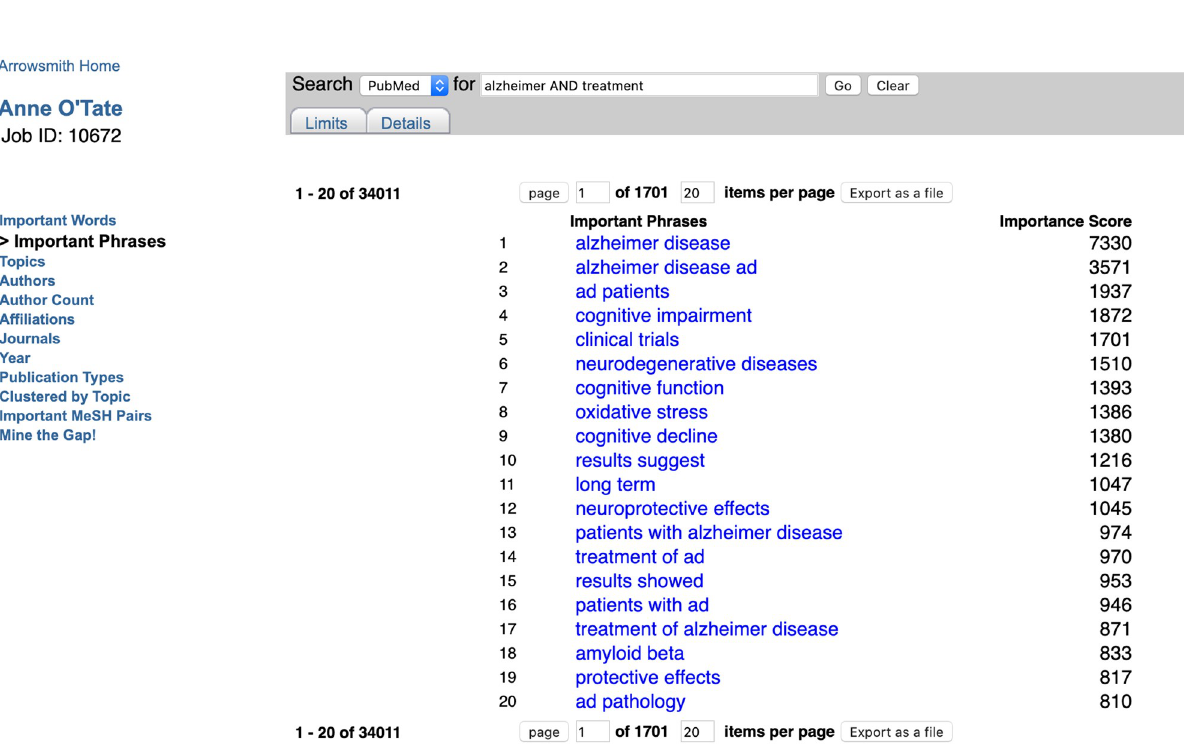
PLOS ONE | https://doi.org/10.1371/journal.pone.0248335 March 8,